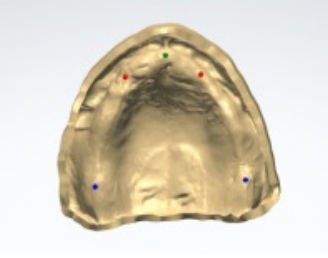
Figure 8. Designing the functional borders of the denture.